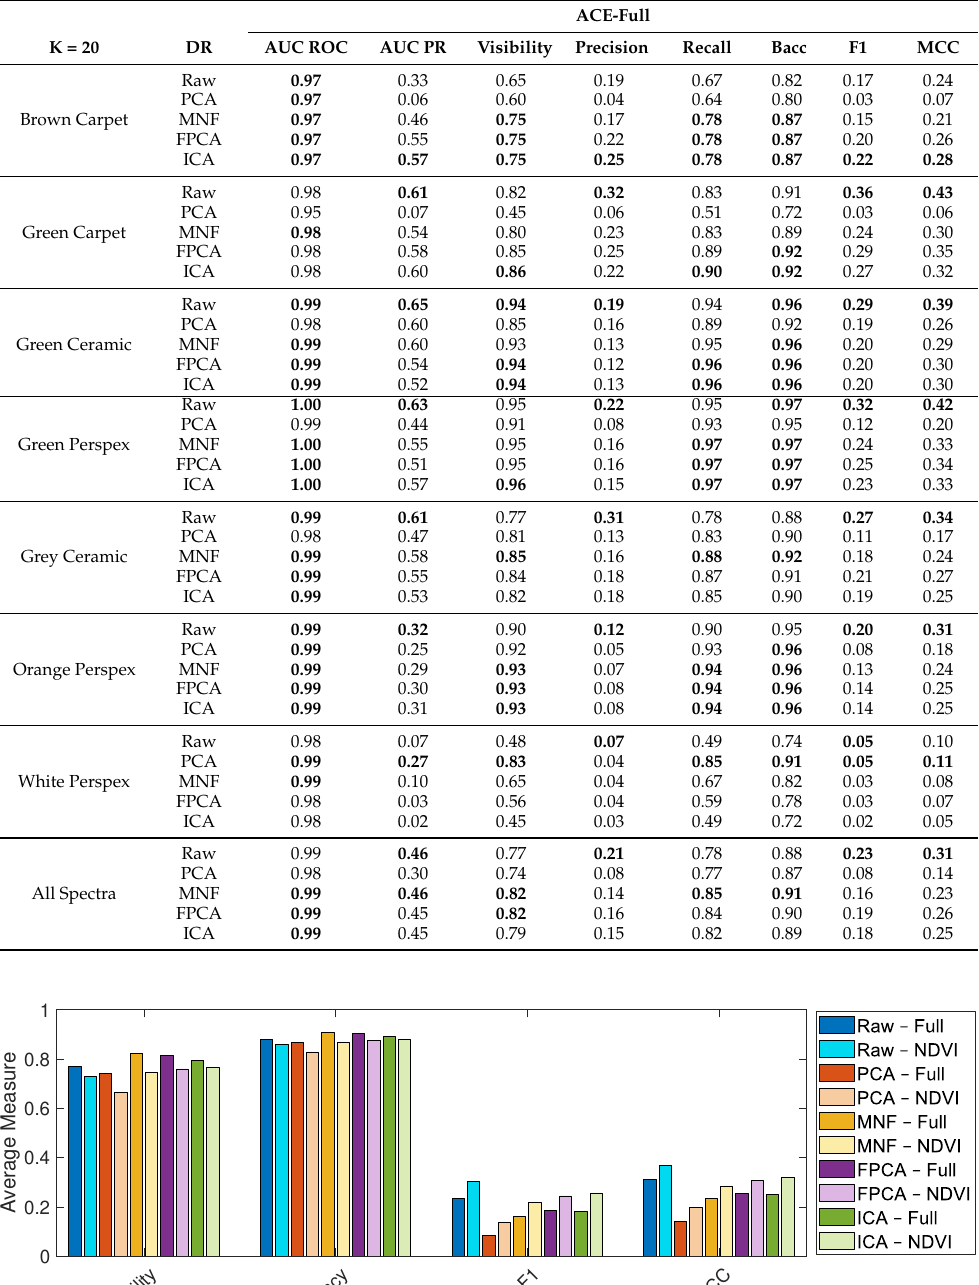
Table 7. Average performance measures for each target in the Selene dataset without spatial DR applied using the ACE algorithm.